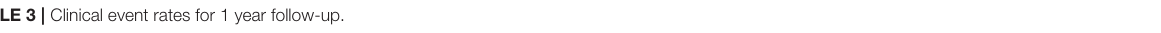
TABLE 3 | Clinical event rates for 1 year follow-up. Before propensity score matching After propensity score